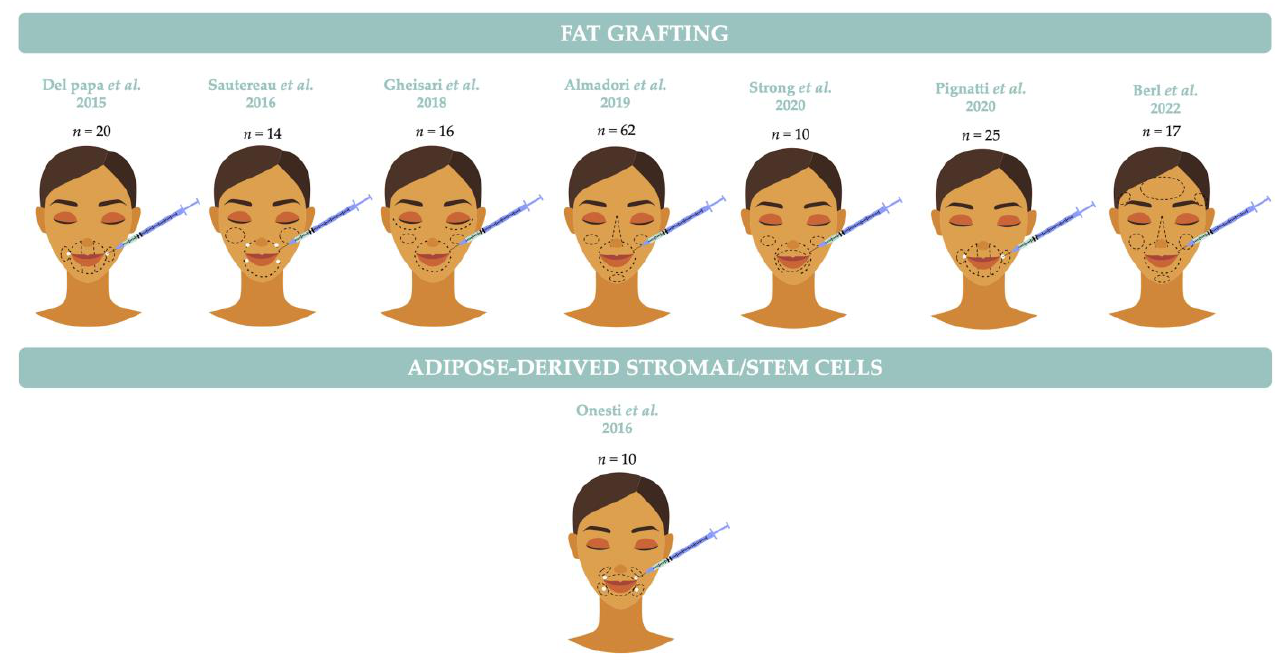
Figure 3. Localization of injections for the treatment of face involvement in systemic sclerosis.